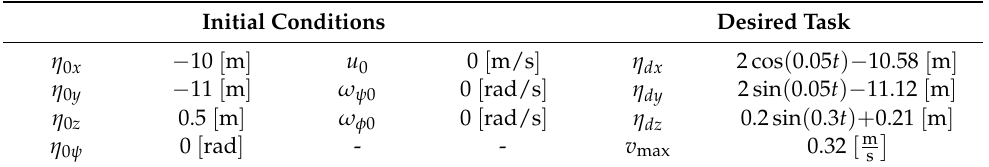
Table 2. Desired task and initial